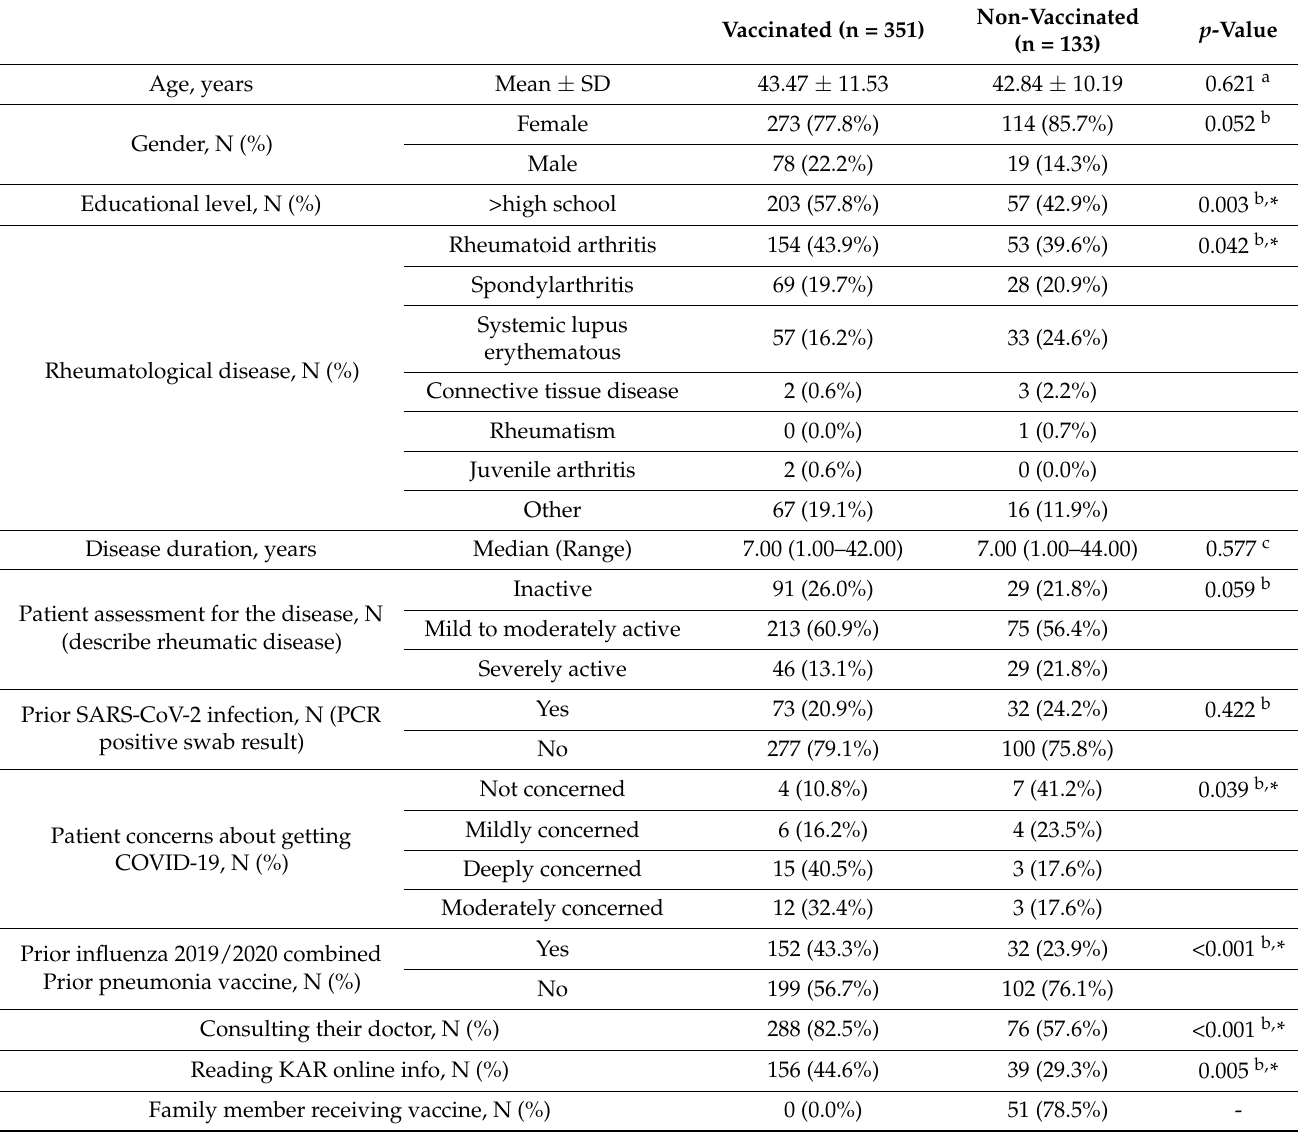
Table 2. Demographic characteristics of the included patients based on vaccination